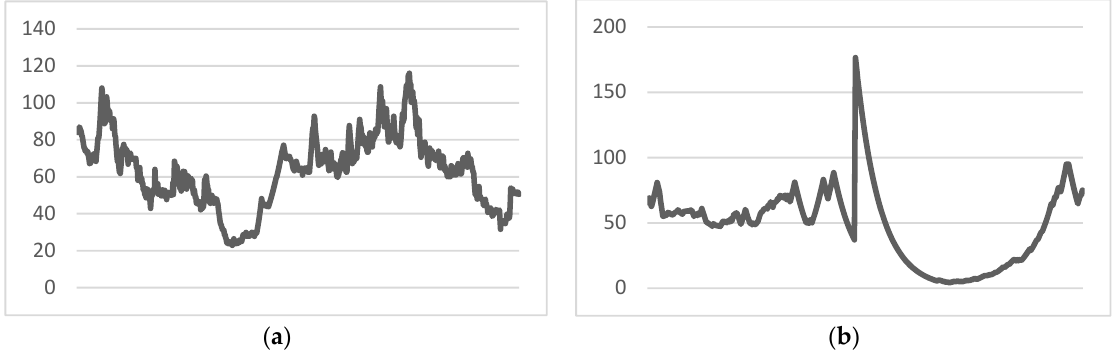
Figure 3. ( a ) Niyogin Fintech Ltd. share price fluctuations from January 2017 to July 2022; ( b ) Polo Queen Industrial and Fintech Ltd. share price fluctuations from January 2017 to July 2022 (BSE 2022).